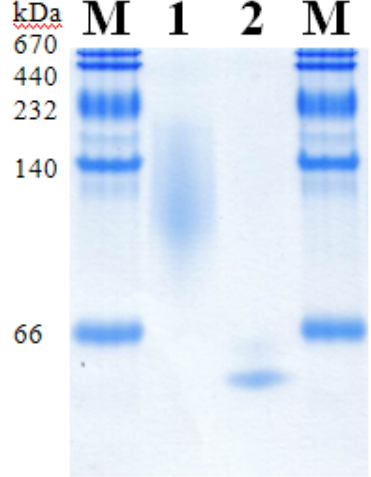
Figure 3. Native PAGE of purified PDHs. M, molecular marker; 1, AcPDH; 2,